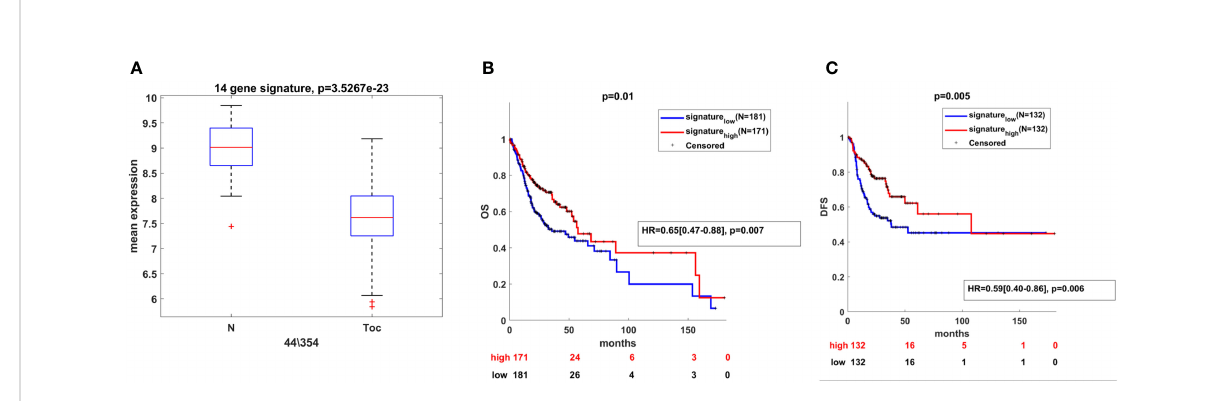
FIGURE 7 Clinical utility of miR-21-5p, miR-93-5p, and miR-155-5p targets in OSCC. (A) Box-plot representing the expression of 14 genes negatively correlated with miR-21-5p, miR-93-5p, and miR-155-5p and differentially expressed between oral tumor tissues and their normal counterparts (P<0.05) in the TCGA OSCC cohort. Kaplan – Meier analysis representing the correlation between expression levels of miR-21-5p, miR-93-5p, and miR-155-5p targets considered as a group and OS (B) and DFS (C) in OSCC patients from the TCGA cohort. The TCGA cohort was divided in high and low groups, based on the positive and negative z-scores of the mean signal of the signature, respectively. The Hazard Ratio was assessed by multivariate cox regression analysis, adjusted for T,N stage and mutP53. For each KM curve, the hazard risk, con fi dence interval, and relative p-value (p) of the multivariate Cox analysis are also indicated.